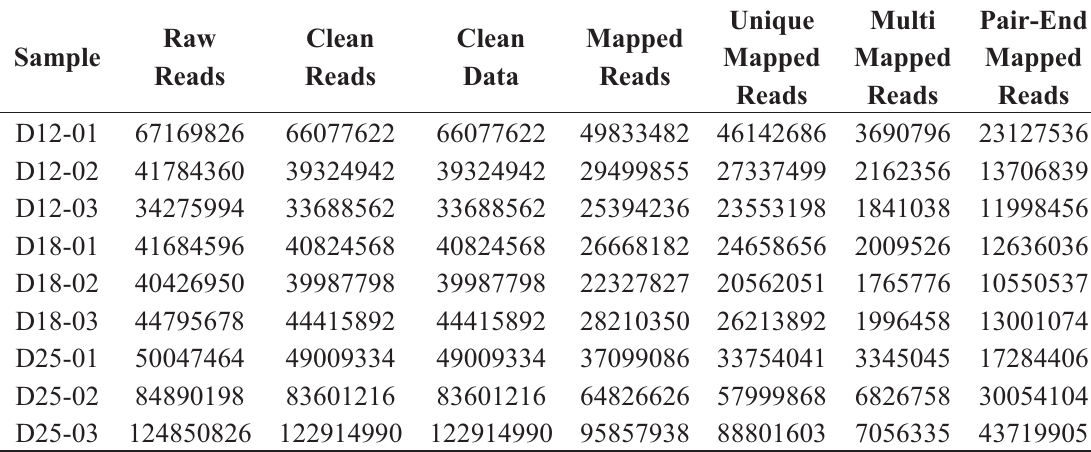
Table 2. Summary of RNA-Seq